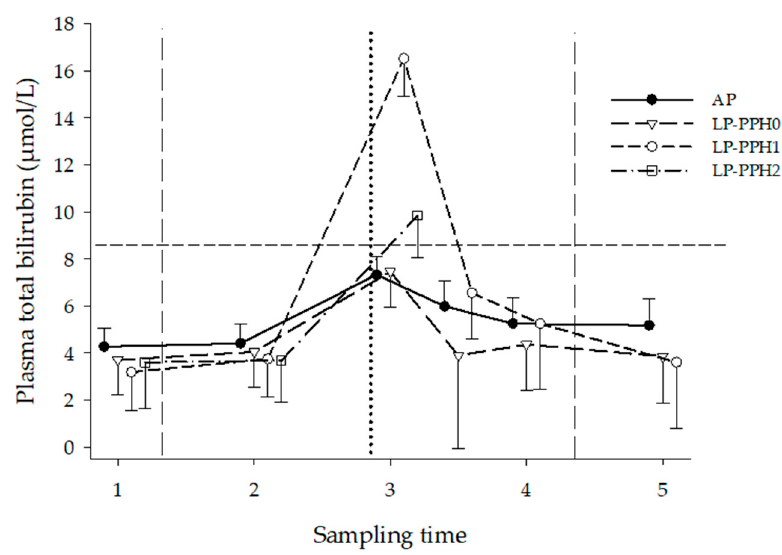
Figure 3. Plasma total bilirubin of dairy cattle receiving either a diet with adequate P content (AP, n = 18) or a P deficient diet (LP, n = 18) in the periparturient period. LP-PPH2: cows that developed clinical PPH (i.e., hemoglobinuria; n = 5), LP-PPH1: cows with subclinical PPH (n = 6); LP-PPH0: cows without evidence for PPH (n = 7). The vertical dashed lines mark the beginning and end of the phosphate depletion and repletion phase of the study. The vertical dotted line indicates calving. The horizontal dashed line presents the upper limit of the reference range for plasma bilirubin in cattle.